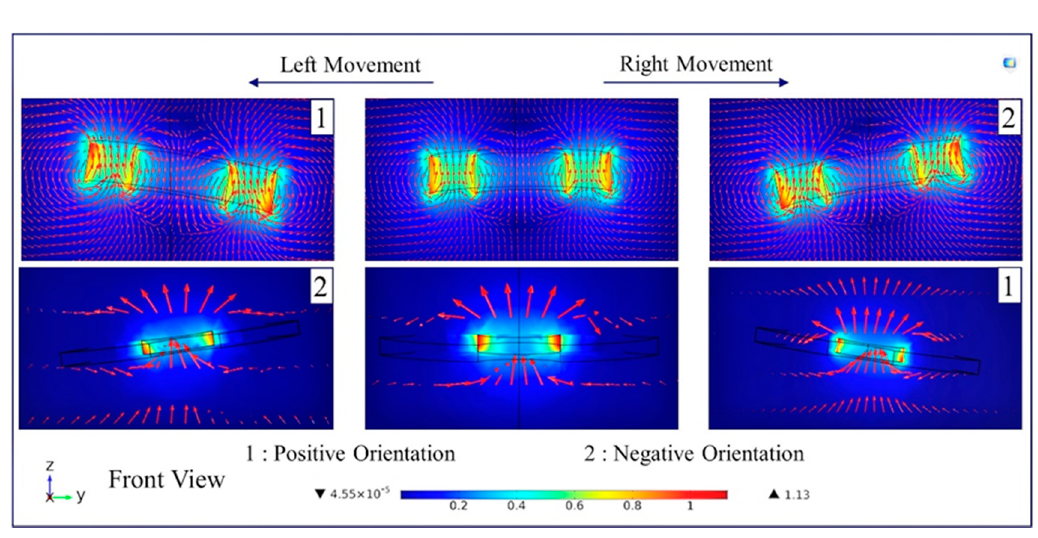
Figure 5. Analysis to find the orientation of the carrier-magnet in order to avoid head-tilting reaction. Accordingly, it is determined that the carrier-magnet must have a direction opposite to the motion direction of the microrobot.